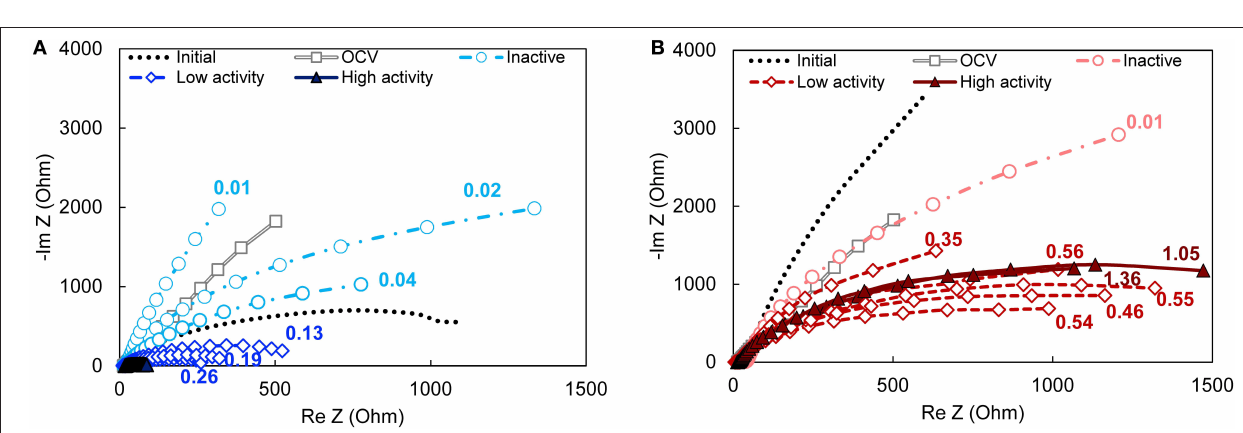
FIGURE 3 | Nyquist plots of bioanodes fixed at (A) E AN = − 0.15V and (B) E AN = + 0.15V taken at the end of the startup cycle. All curves in the same plot are replicates. The magnitude of impedance is lower when the ratio of the curve is lower, which translates into lower total resistance. High-, low-activity, and inactive bioanode levels are defined based on the time required to reach the startup current threshold ( Figure 1 ). The numbers next to each curve are the current density recorded at the end of the startup period. OCV, open circuit voltage (gray double line with squares); Initial—prior to inoculation (dotted